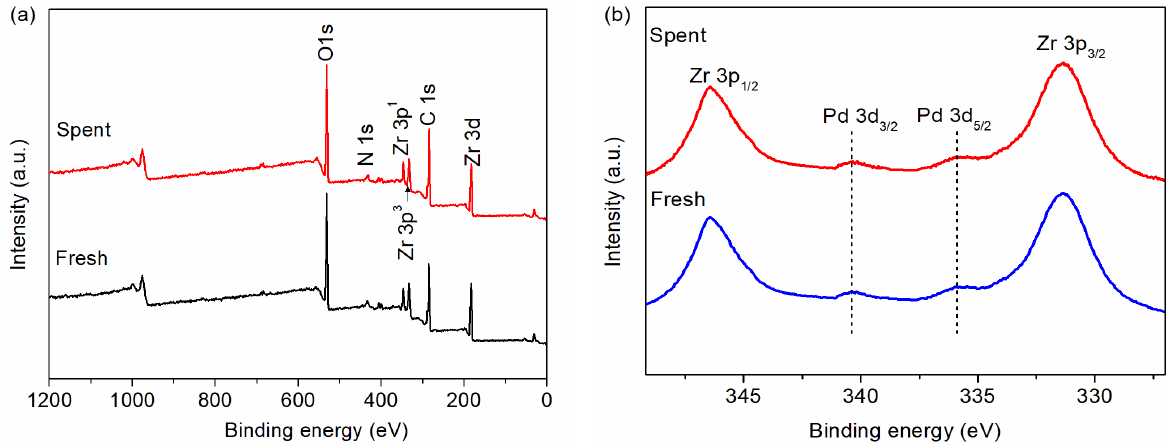
Figure 13. XPS spectra of Pd/UiO-66-NO 2 - 7 ( a ) survey spectrum, ( b ) high-resolution XPS spectra of Zr 3p and Pd 3d.